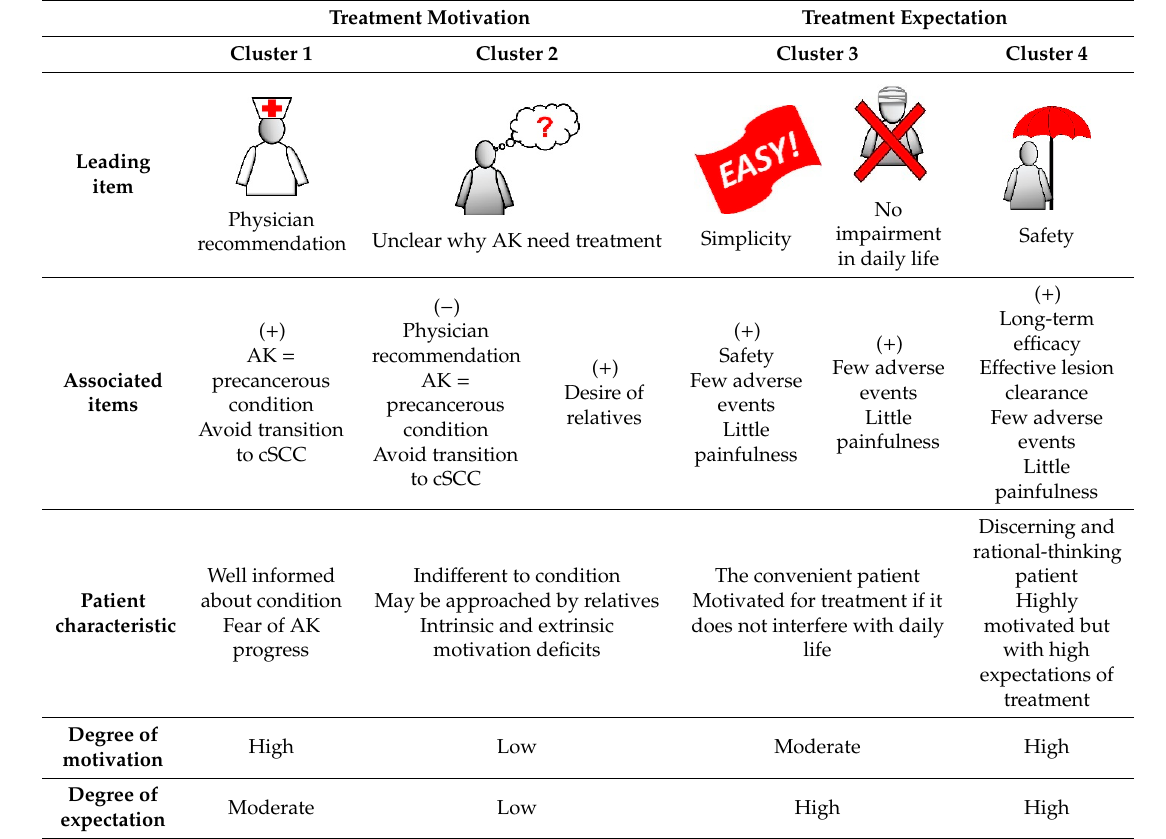
Table 2. Summary of treatment motivation and treatment expectation profiles.